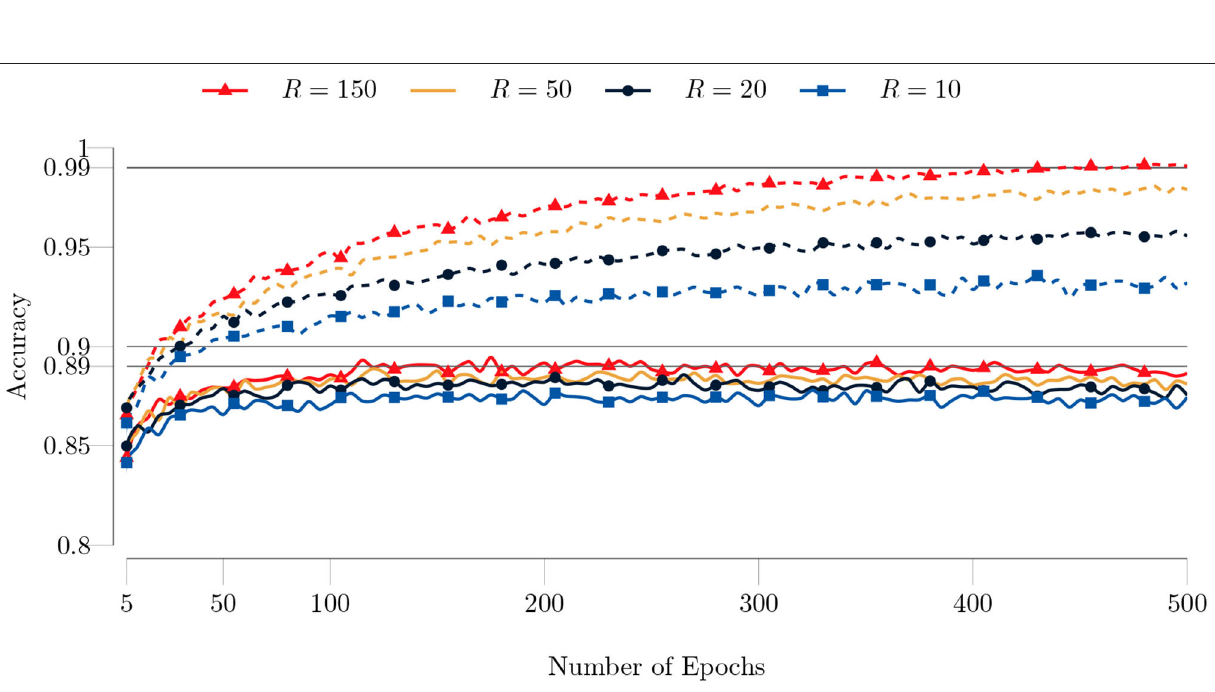
Frontiers in Applied Mathematics and Statistics |